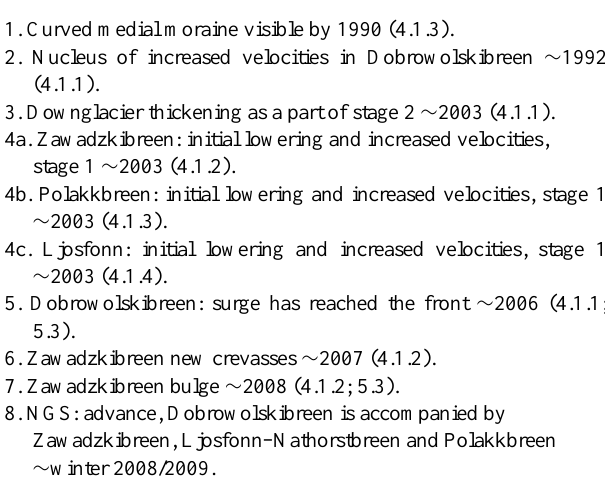
Fig. 11. Progress of surge events in NGS. Events indicated by num- ber and results and discussion references in brackets. Background image by SPOT SPIRIT 2008 ©